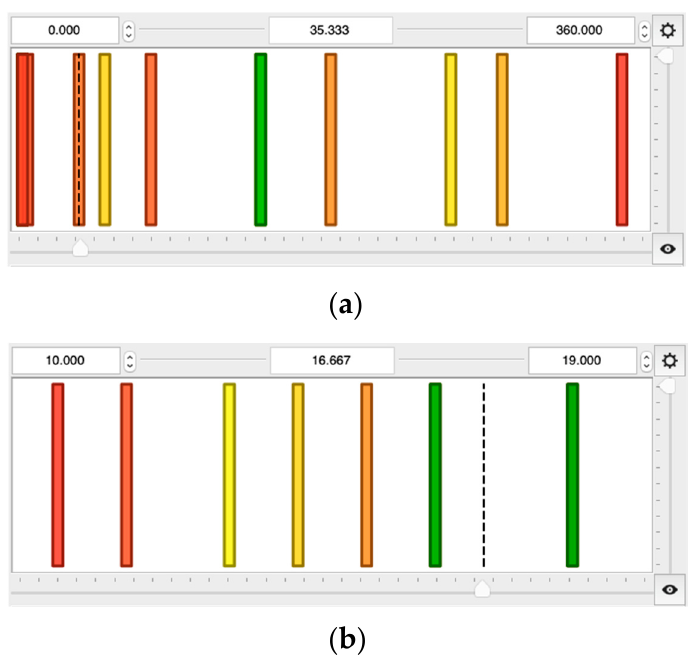
Figure 5. Membership functions for output parameters; x-axes correspond to the mass of the grinding product ( a ) and mean Sauter diameter of the product ( b ) from Table 2, whereas y-axes express membership function value.